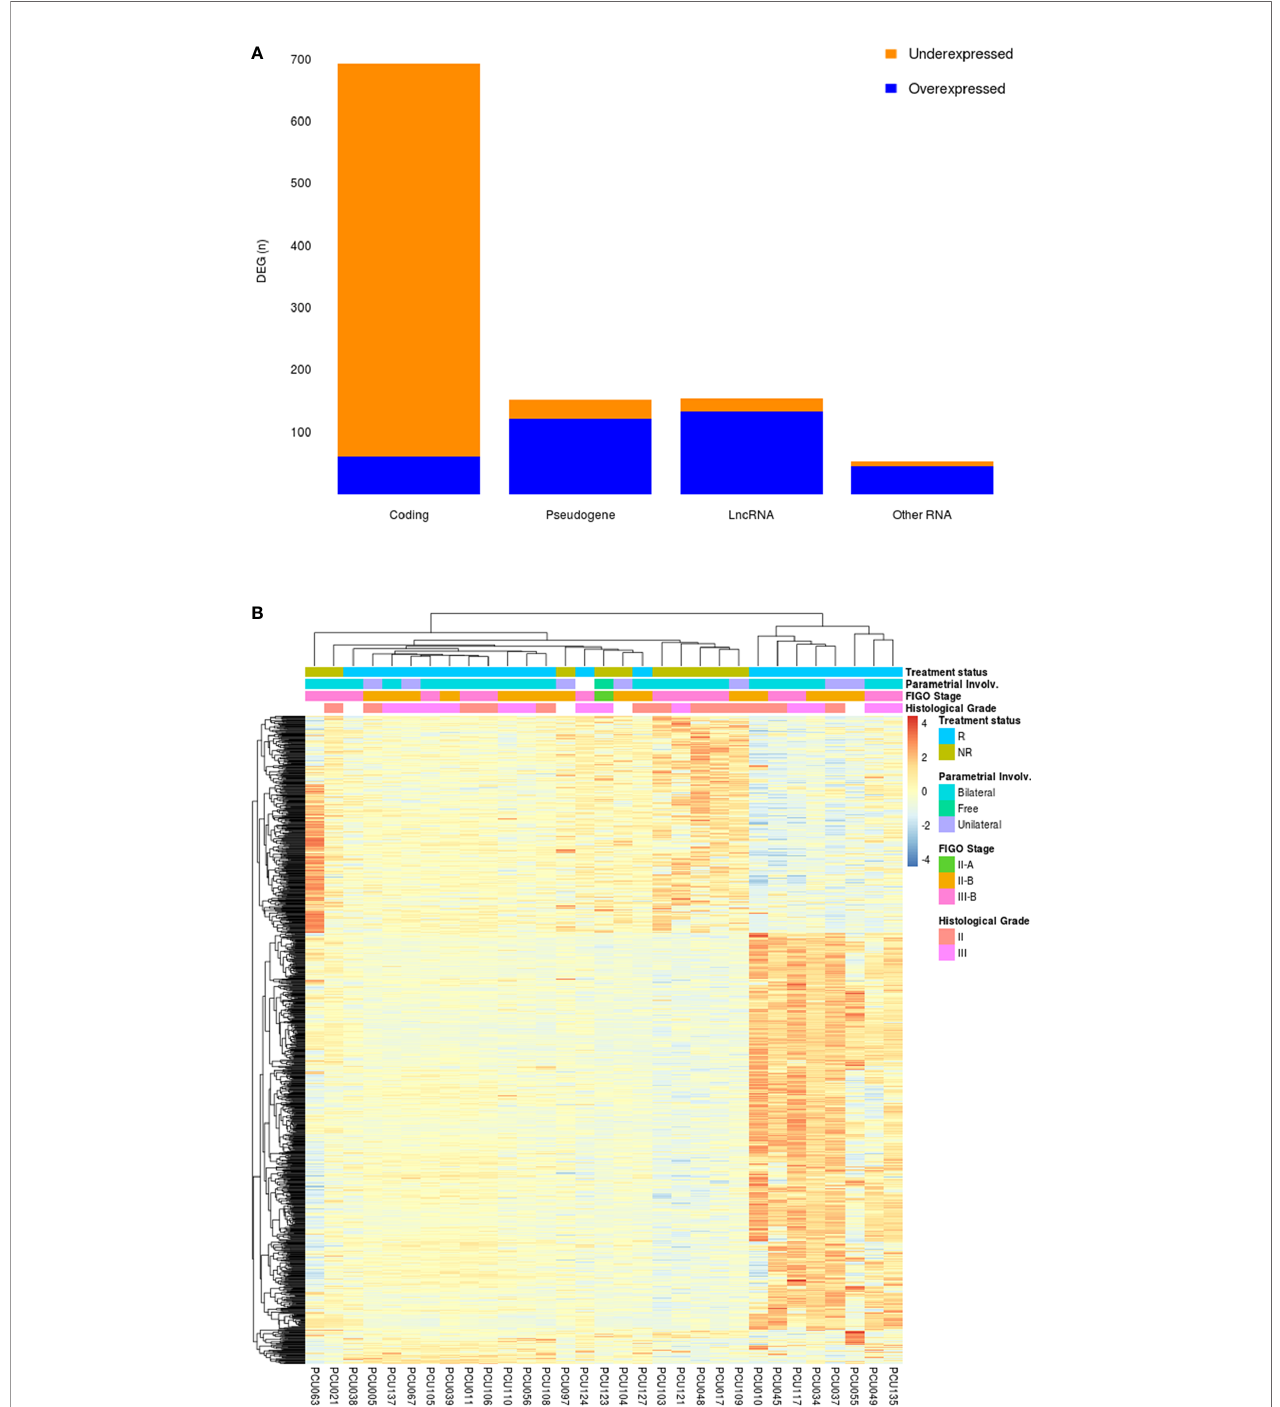
FIGURE 2 | (A) Frequency of DEGs from cervical cancer stem-like cells in Non-Responder (n=10) compared to Responder patients (n=21). From the 1050 DEGs (adjusted p-value < 0.05), 694 protein coding, 150 pseudogenes, 154 long non-coding RNAs (LncRNA) and 52 transcripts classi fi ed as “ Other RNA ” (snoRNA, miRNA, miscRNA, TEC, snRNA and mitochondrial rRNA) were identi fi ed. Orange and blue colors represent the proportion of under and overexpressed DEG transcripts in each category, respectively. (B) Heatmap showing 1050 differential expressed genes (adjusted p-value < 0.05) in cervical cancer stem-like cells. Responder patients (R; n=21) are represented in blue and Non-Responders (NR; n=10) are colored in green. Clinical features of Parametrial involvement, FIGO Stages and Histological grades are detailed in the fi